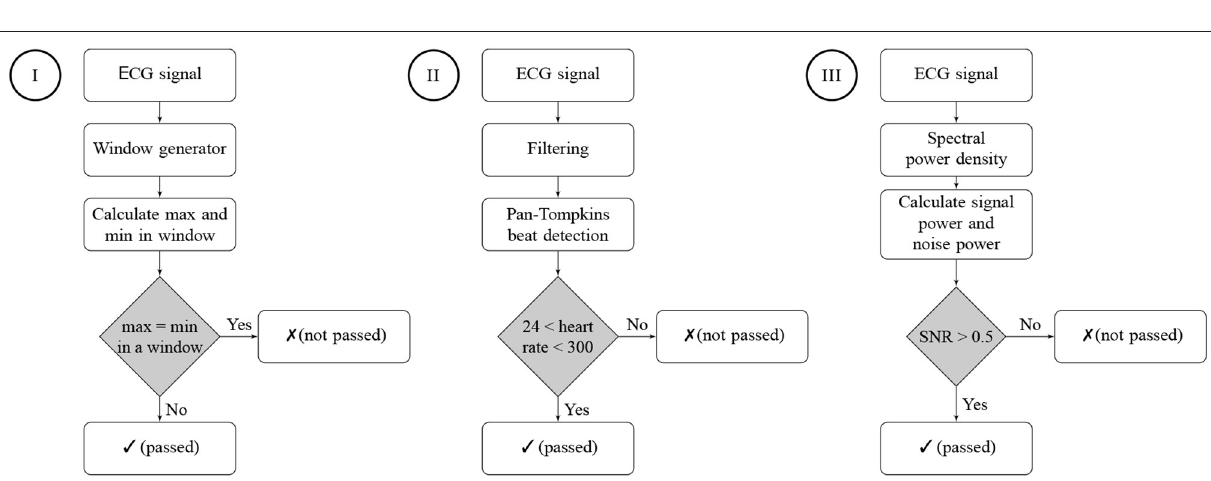
FIGURE 3 | Flowcharts of the three signal quality classification algorithms. Algorithm I is a stationary check, Algorithm II is a heart rate check, and Algorithm III is an SNR check. A passed status on an algorithm means that no characteristics of a low-quality signal were detected. A not-passed status means that characteristics of poor quality were detected for the ECG